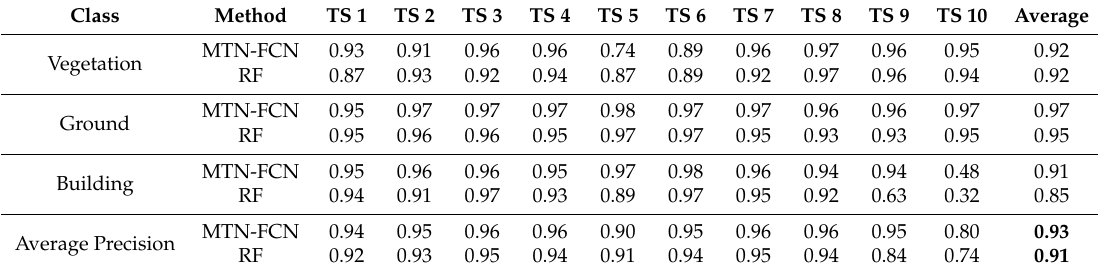
Table 8. Precision values of the AHN3 dataset. TS: testing set.